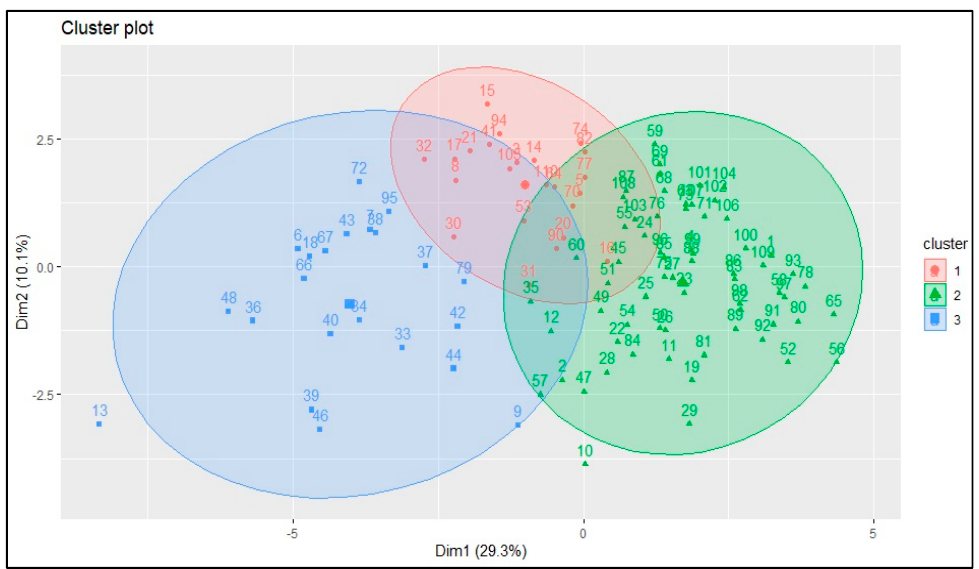
Figure 4. Ascending hierarchical classification of the articles, revealing 3 clusters. Each Roman numeral in the scatterplot indicates the article serial number.